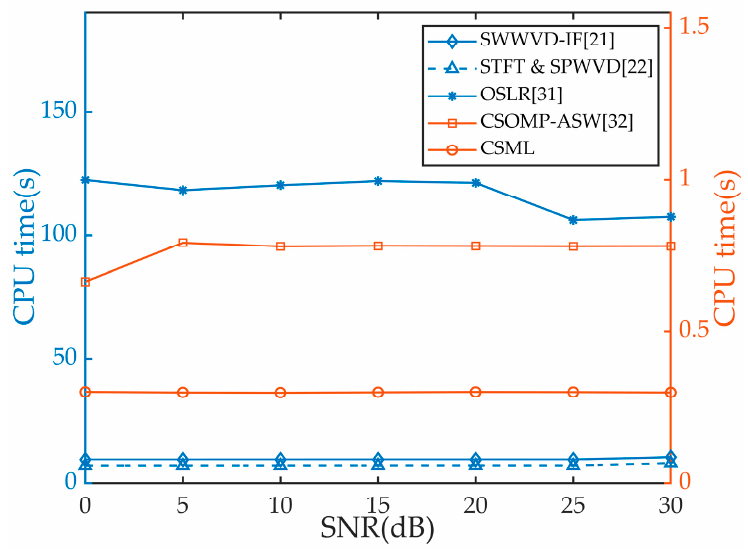
Figure 14. CPU time consumed by the five algorithms in the estimation process of hopping time. Table 4. The MSE of the hopping-time estimation of the five algorithms under different SNR conditions. Table 5. The average CPU time consumed by the five algorithms in the process of estimating the hopping time.